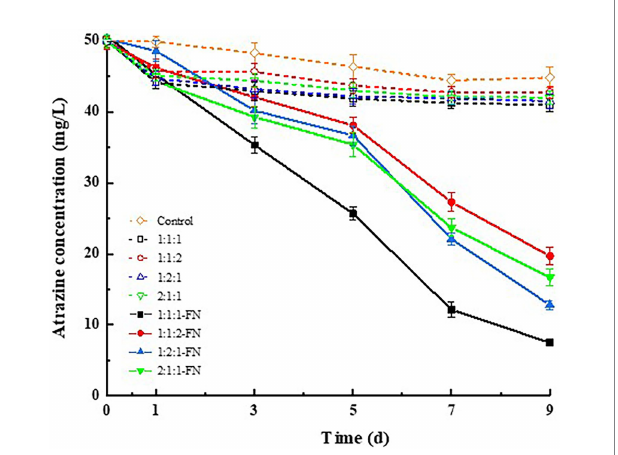
FIGURE 1 Degradation effect of atrazine by three types of carrier materials (i.e., rice straw powder, rice husk, and wheat bran) at varied ratios with or without the bacterial suspensions